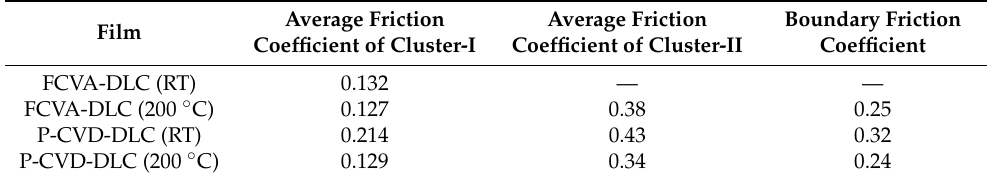
Figure 7. Contour plot and overhead view of cluster analysis data for friction coefficient of FCVA-DLC film. ( a ) RT; ( b ) 200 °C. Table 1. Average friction coefficient of cluster I and II.